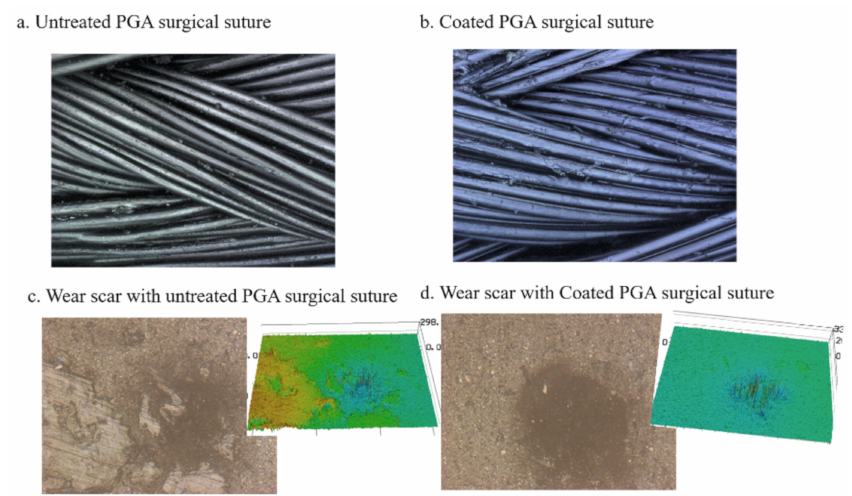
Figure 10. Wear morphology of the surgical sutures and the skin substitute. ( a ) Untreated surgical suture; ( b ) coated surgical suture; ( c ) wear scar with untreated surgical sutures; ( d ) wear scar in skin substitute with coated surgical